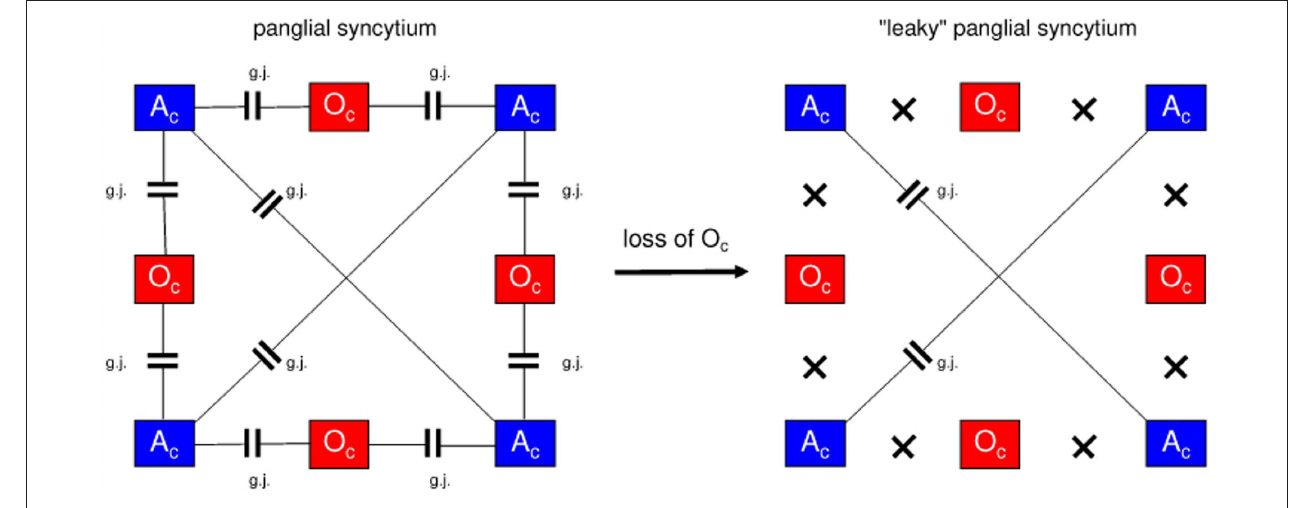
Figure 10 | Loss of oligodendrocytes disconnects the panglial syncytium, causing memory impairment in schizophrenia. On the left, a panglial syncytium composed of astrocytes (Ac) and oligodendrocytes (Oc)